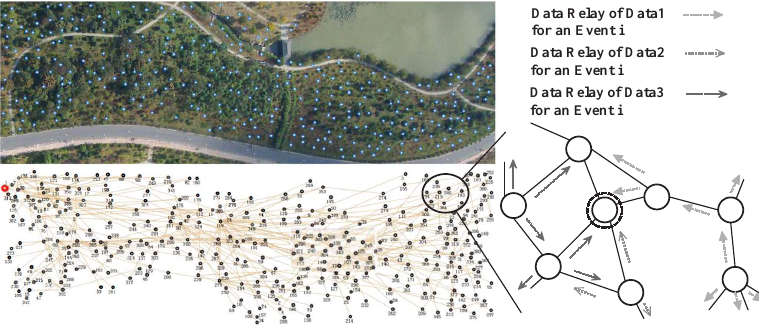
Figure 1. An overlook on the large-scale sensor network deployment and the real topology.